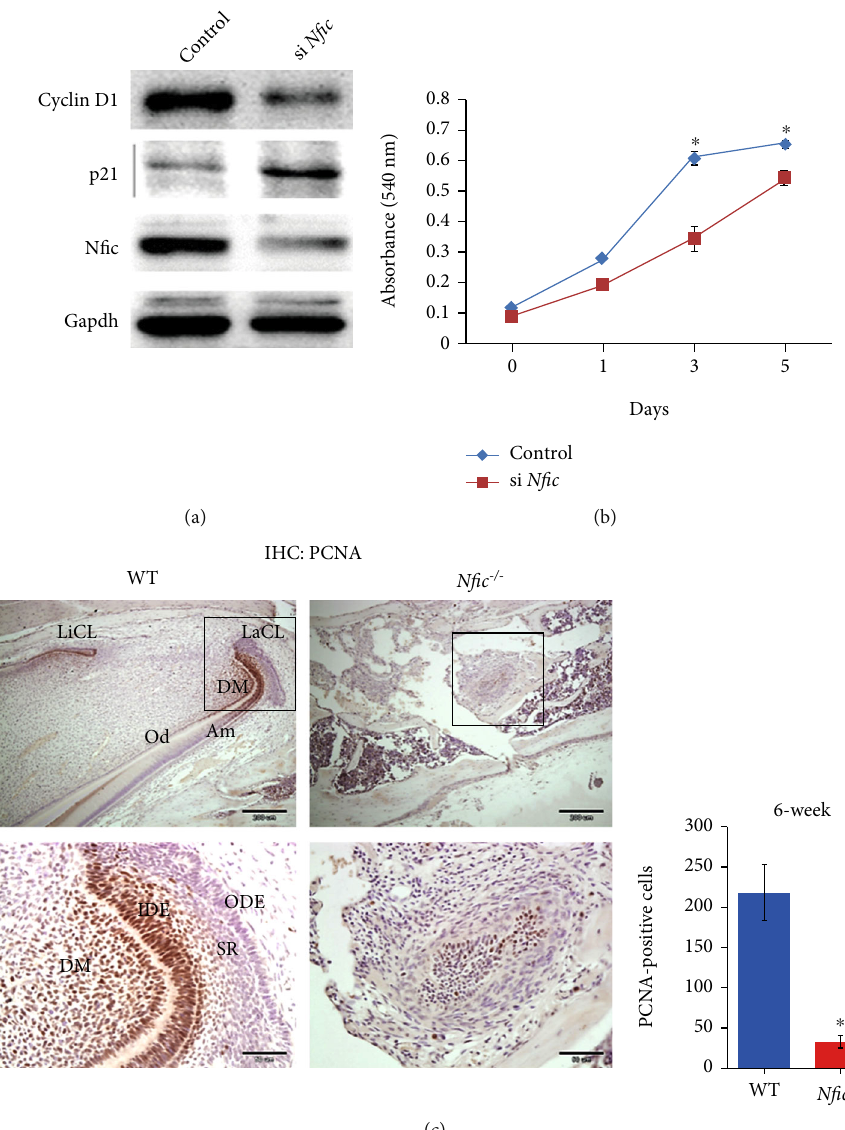
Figure 3: Loss of N fi c decreases the proliferation of dental epithelial cells. (a) Western blot analyses to evaluate the expression levels of cyclin D1 and p21 in control and N fi c -silenced cells. (b) The proliferation rate of control and N fi c -silenced cells from day 0 to 5. n = 5 , ∗ p < : 05 . (c) Immunohistochemistry (IHC) staining analysis of PCNA-positive cells in the cervical loop of the (a, b) control and (c, d) N fi c -silenced mice. (e) The number of PCNA-positive cells in the cervical loop of these mice after 6 weeks. n = 5 , ∗ p < : 05 . (b) and (d) are higher magni fi cations of (a) and (c), respectively. Scale bars = ð a Þ and ð c Þ = 200 μ m ; ð b Þ and ð d Þ = 50 μ m . Data are presented as the mean ± SD . Abbreviations: DM: dental mesenchyme; IEE: inner enamel epithelium; OEE: outer enamel epithelium; SR: stellate reticulum; TA: transit-amplifying cells; WT: wild